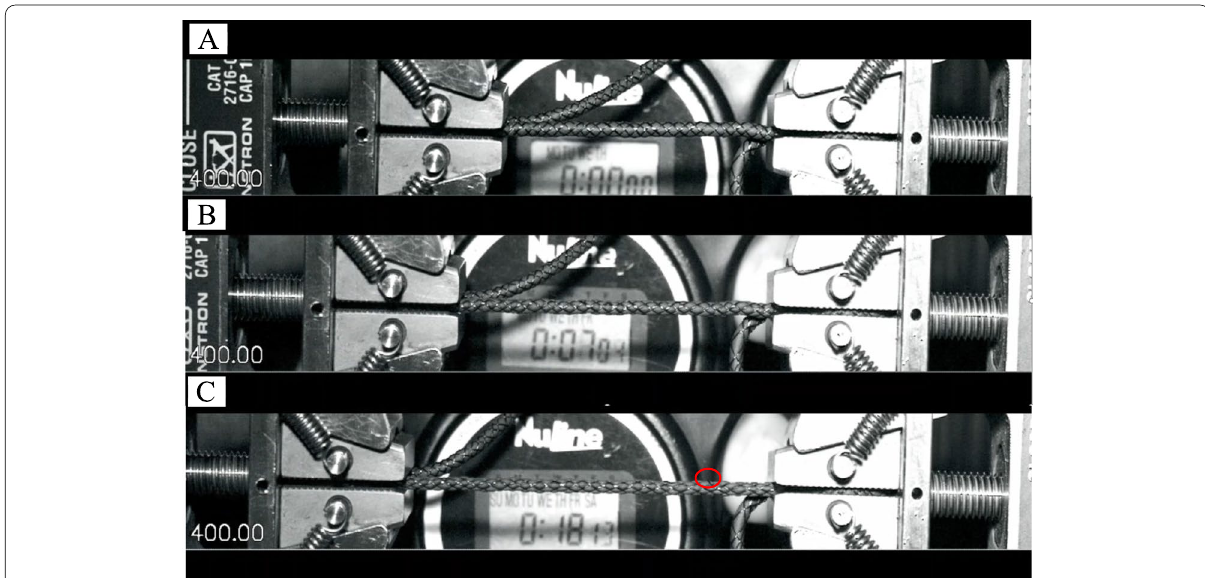
Fig. 8 Pictures of different times during the tensile test measurement. A - at the beginning 0 s, B at 7.04 s- ‘squeezing out’ (failure mode 1) starts to occur, and c 18.13 s first failure mode 2 appears